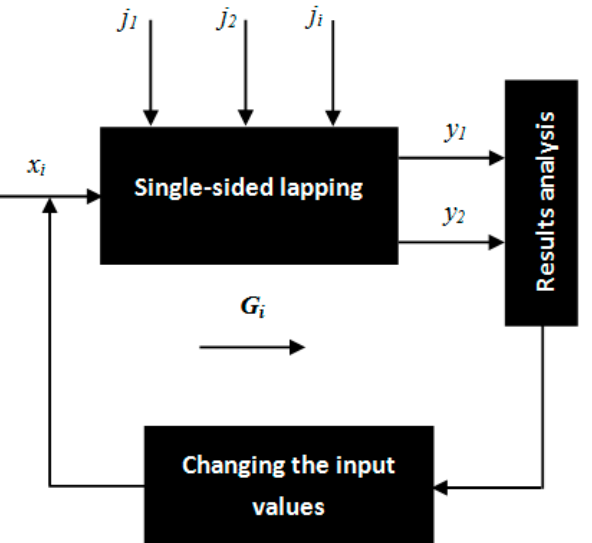
Figure 3. Scheme of the research tests of single-sided lapping with the prototype tool made by the SLS method. Characteristics of factors: X—independent variables: x 1 — type of abrasive